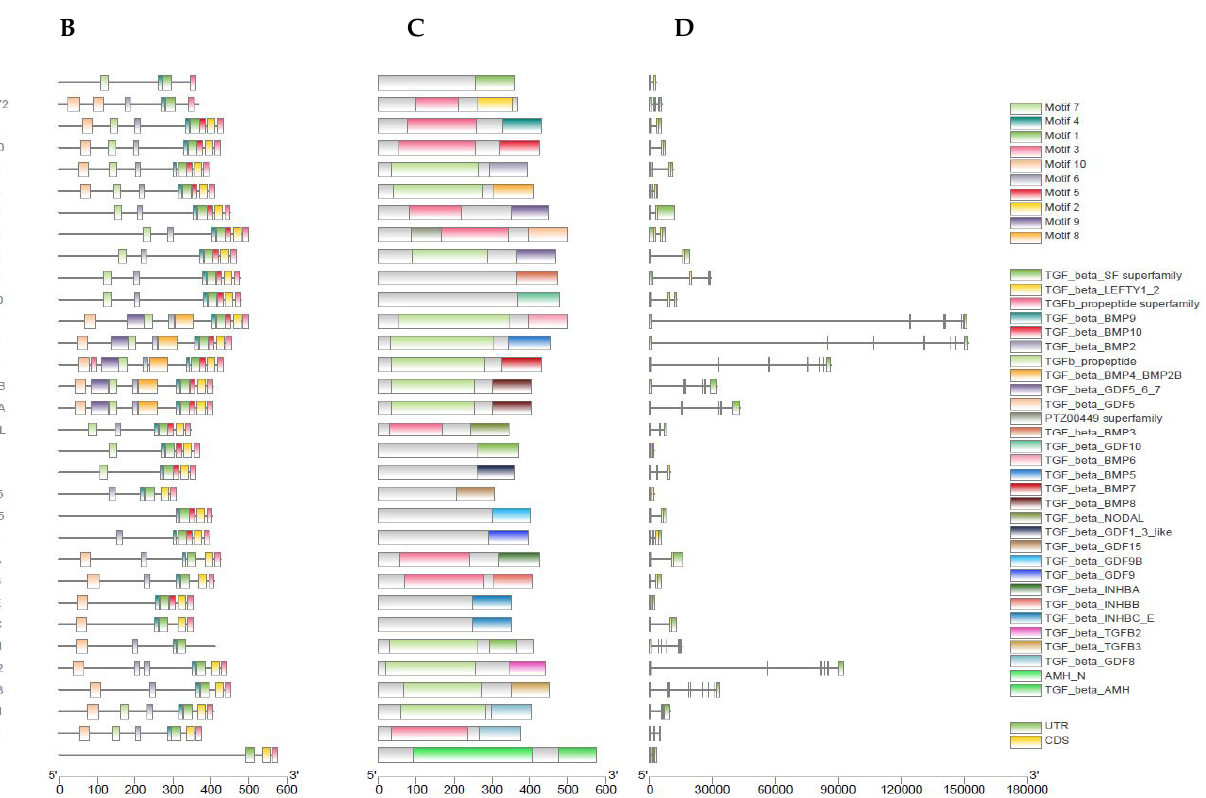
Table 1. Ten substantially conserved motifs identified in TGF- β gene family of buffalo.